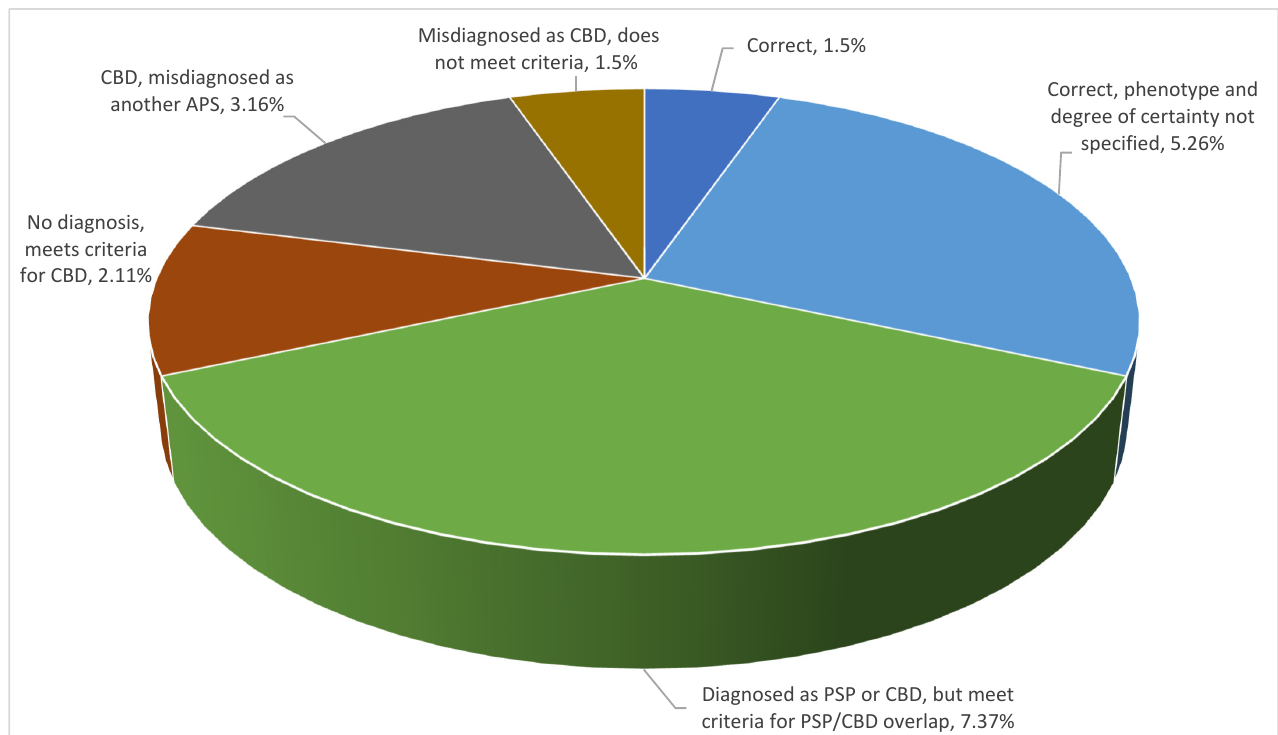
Figure 7. Diagnostic precision per type of atypical parkinsonism: PSP.